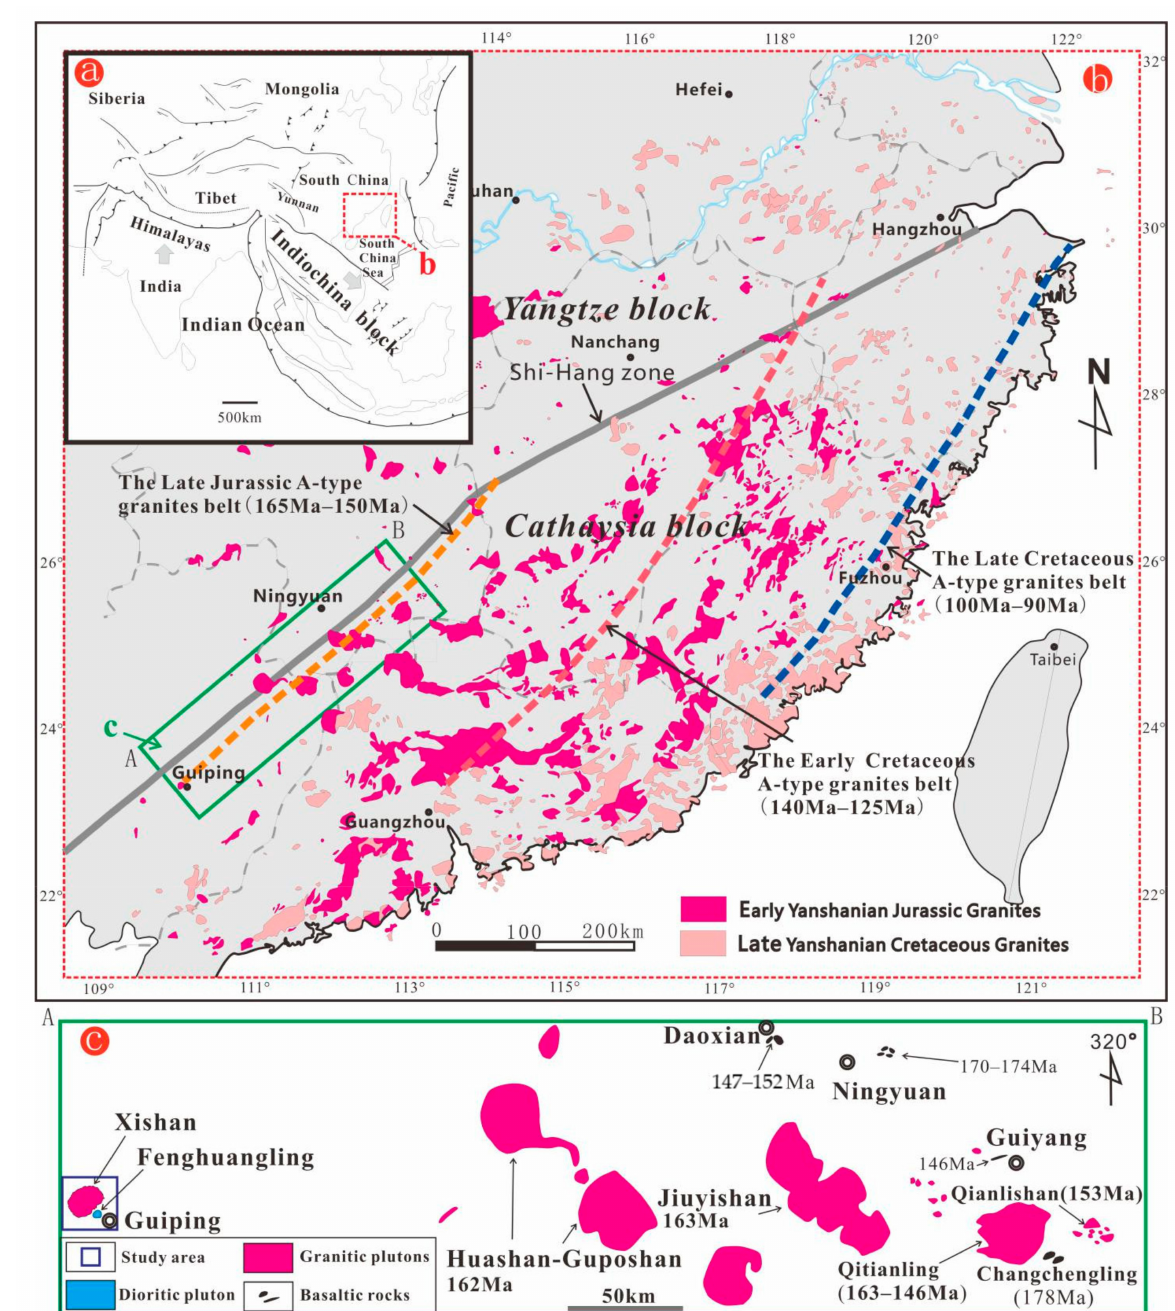
Figure 1. ( a ) A structural outline of Southeast Asia showing the distribution of principal continental blocks. ( b ) The distribution of Yanshanian granites in southeastern China (based on the map from [2,18]). ( c ) The distribution of Jurassic A-type granites in the southwest of the Shihang